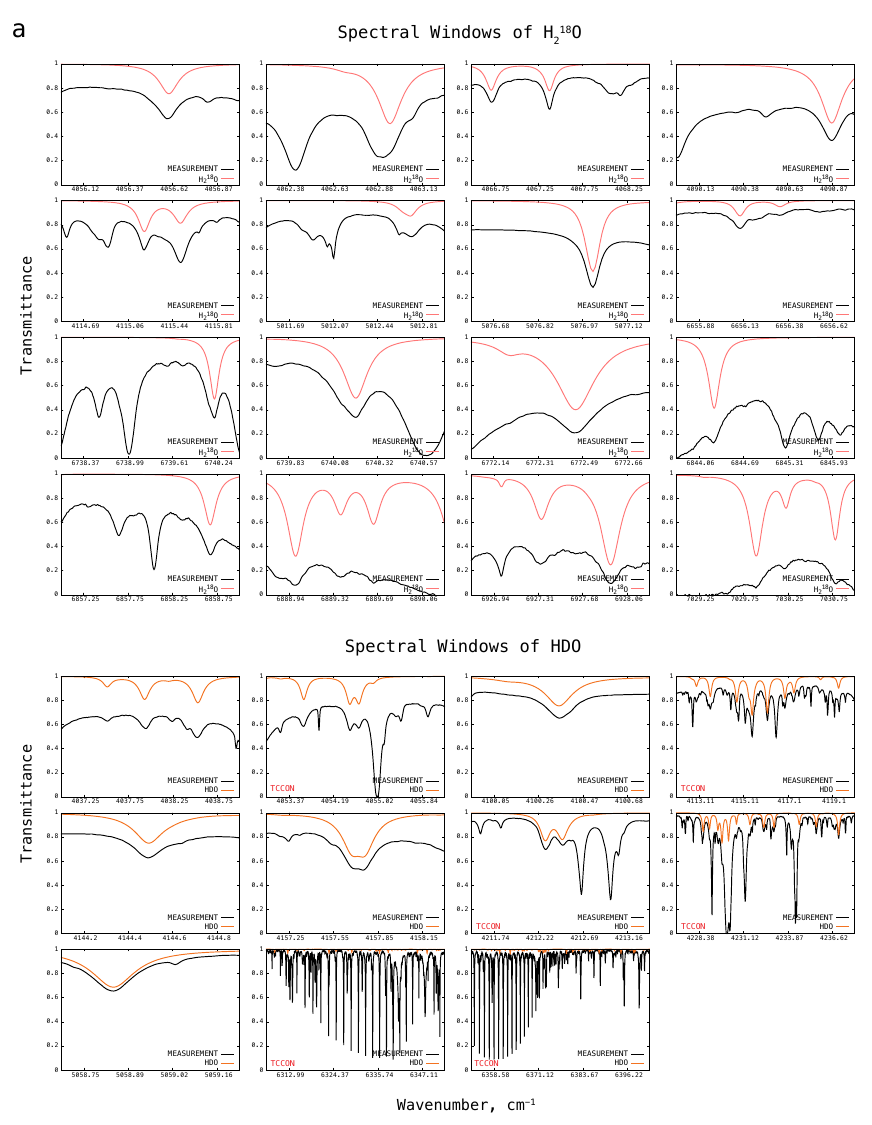
Figure 1a. Refined set of spectral windows for H 18 and HDO, respectively. “TCCON” inscription indicates spectral windows used by the TCCON